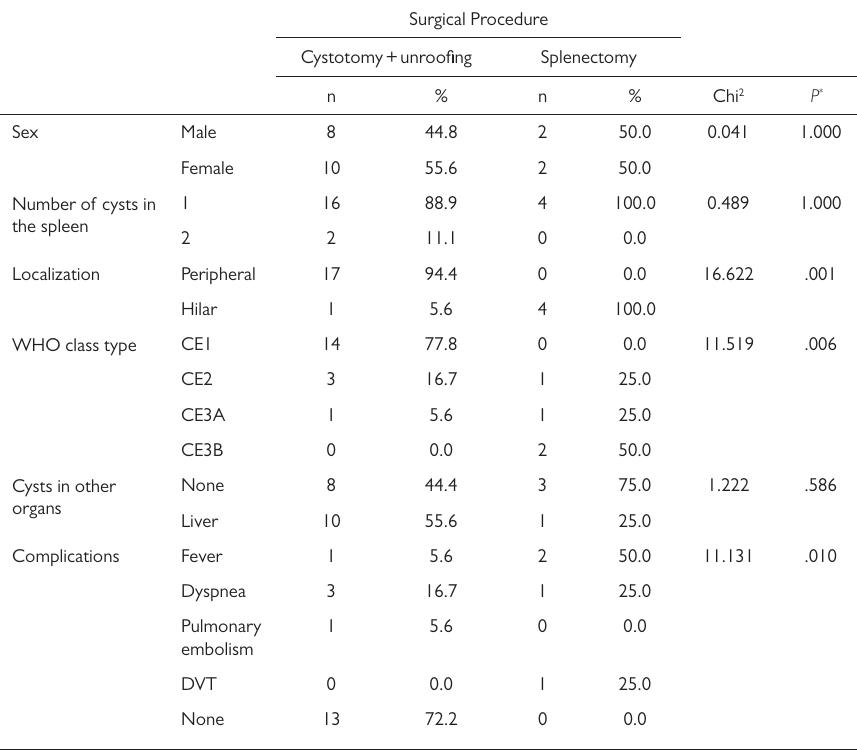
Table 2. Comparison of Categorical Variables Between Patients Undergoing Splenectomy and Spleen-Preserving Interventions